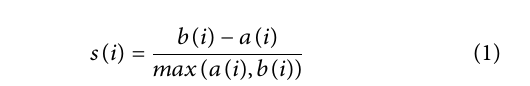
Frontiers in Robotics and AI |